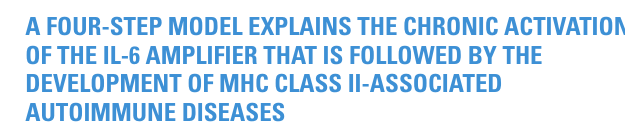
FIGURE 1 | IL-6amplifier activation plays a role in the development of autoimmune diseases such as arthritis in F759 mice and EAE. IL-17A-triggerred positive feedback of IL-6 signaling, which results in synergistic hyper-expressions of chemokines and IL-6 itself in type 1 collagen + cells, is enhanced in a manner dependent on NF- κ B and STAT3, which our themselves stimulated by IL-17A in the presence of an IL-6 signal